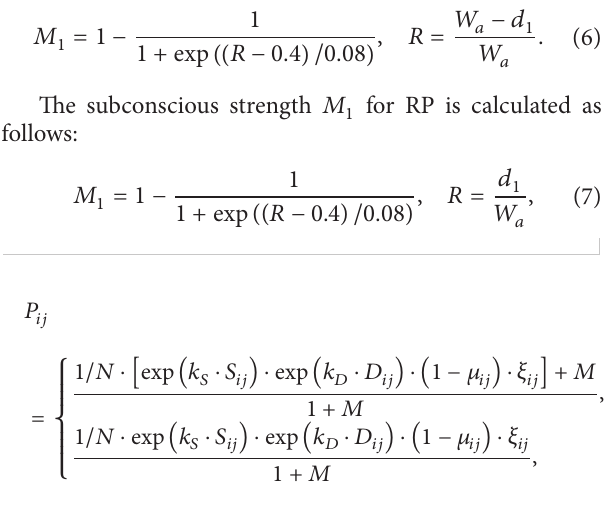
where 𝑀 is subconscious strength of LP (RP); 𝑀 1 is the subconscious strength formed by the horizontal position of LP (RP); 𝑀 2 is the subconscious strength formed by the vertical position of LP (RP); 𝛼 is the undetermined coefficient, and 0 < 𝛼 ≤ 1